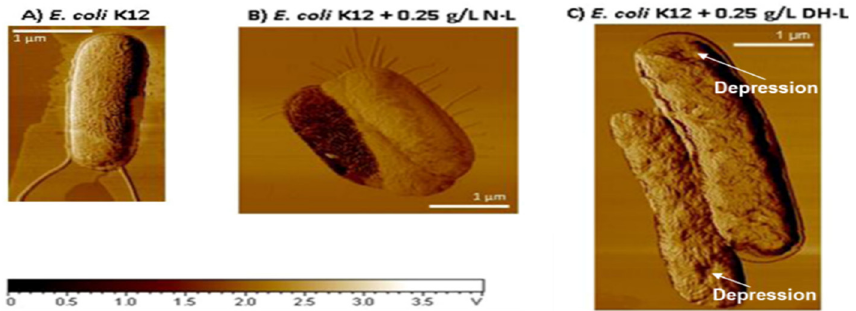
Figure 2. AFM phase imaging: Non-treated E. coli K12 cells ( A ); cells treated with native lysozyme (N-L) at 0.25 g/L ( B ); cells treated with dry-heated lysozyme (DH-L) at 0.25 g/L ( C ). The z-range is from 0 to 4 V. “Reprinted with permission from [52]. Copyright © 2022 American Chemical